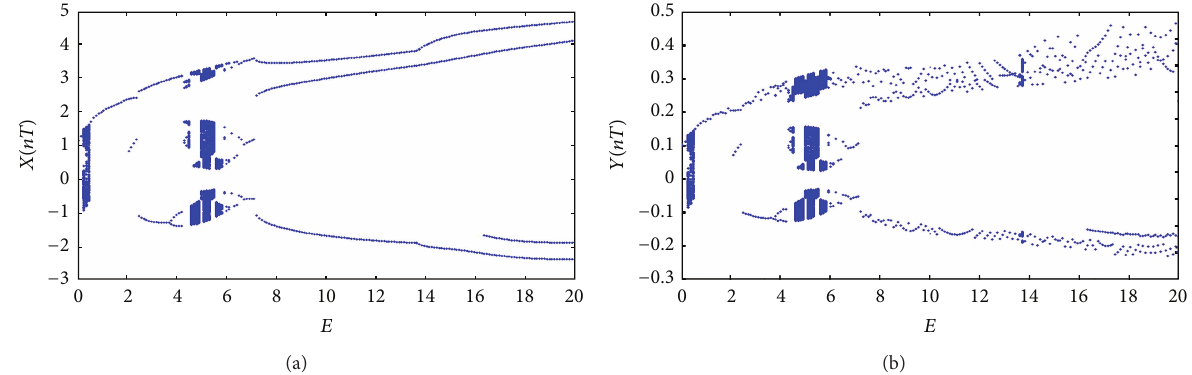
Figure 3: Bifurcation diagrams for variation of blood vessel diameter (𝑋) and change in blood pressure (𝑌) using vibrational amplitude (𝐸) as bifurcation parameter: (a) 𝑋(𝑛𝑇) and (b) 𝑌(𝑛𝑇) .